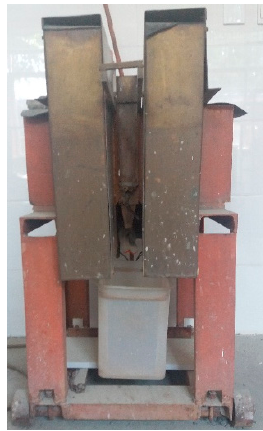
Figure 1. The device used for kerosene magnetizing treatment.